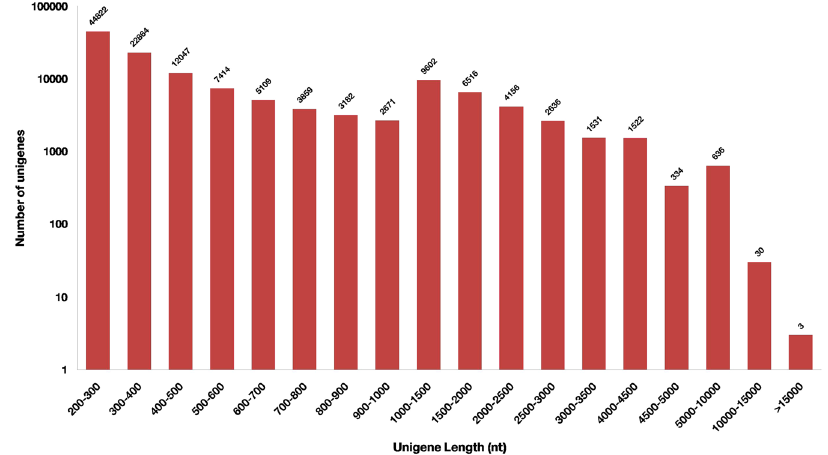
Figure 1. Overview of unigene length distribution from Solanum trilobatum leaf transcriptome.